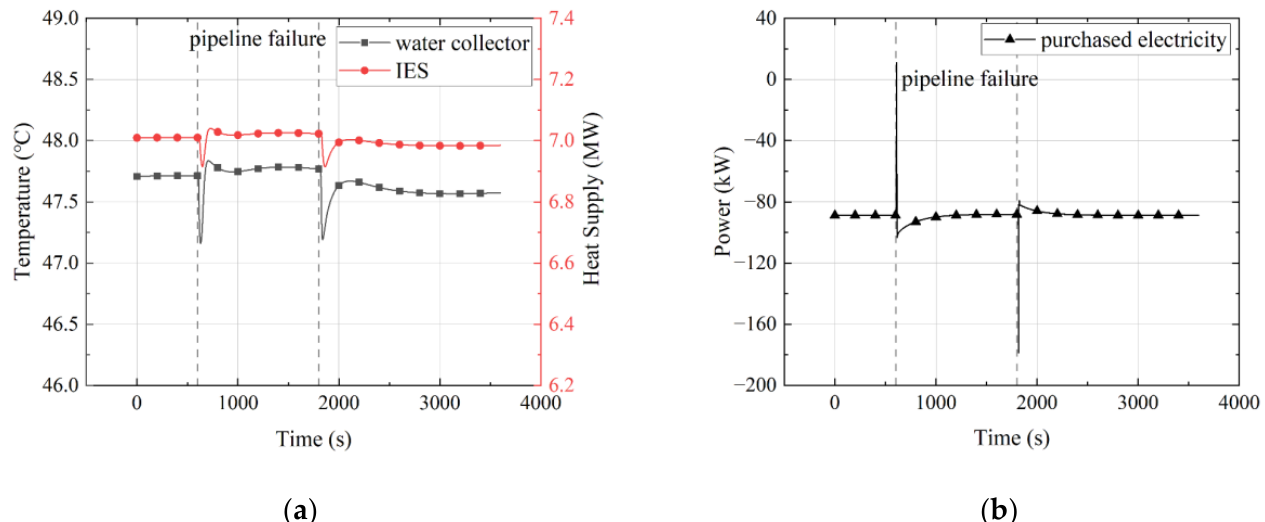
Figure 10. Response of IES with the AA-CAES method. ( a ) heat subnet; ( b ) power subnet.